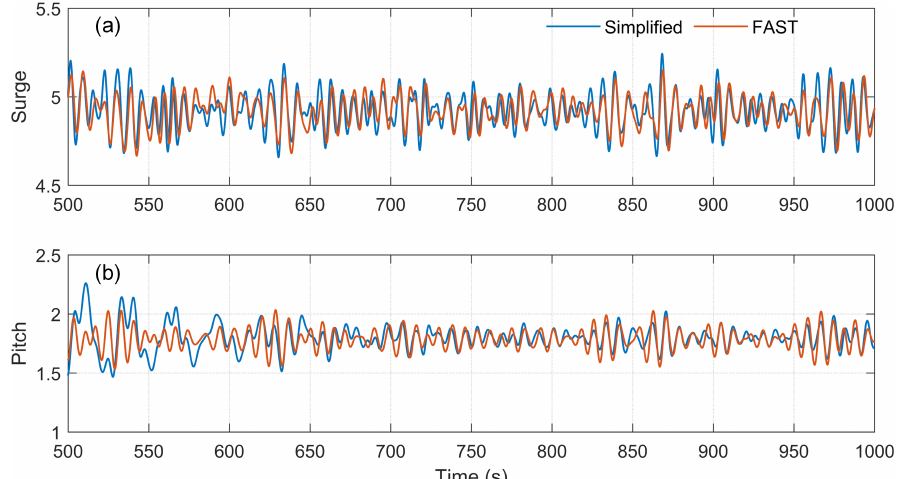
Figure 11. Time response of motion RAO for semi-submersible floater under irregular wave: ( a ) Surge; ( b )